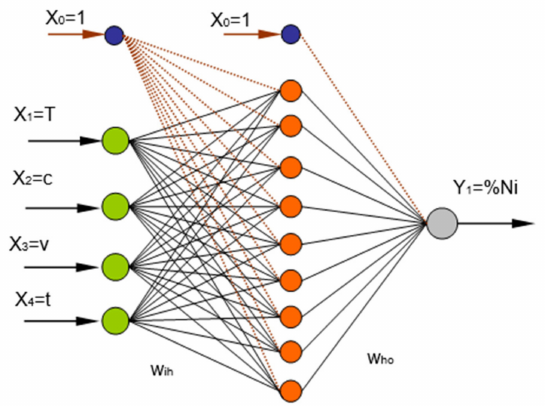
Figure 2. Signal flow in BP neural networks with four input neurons, nine hidden neurons, and one output